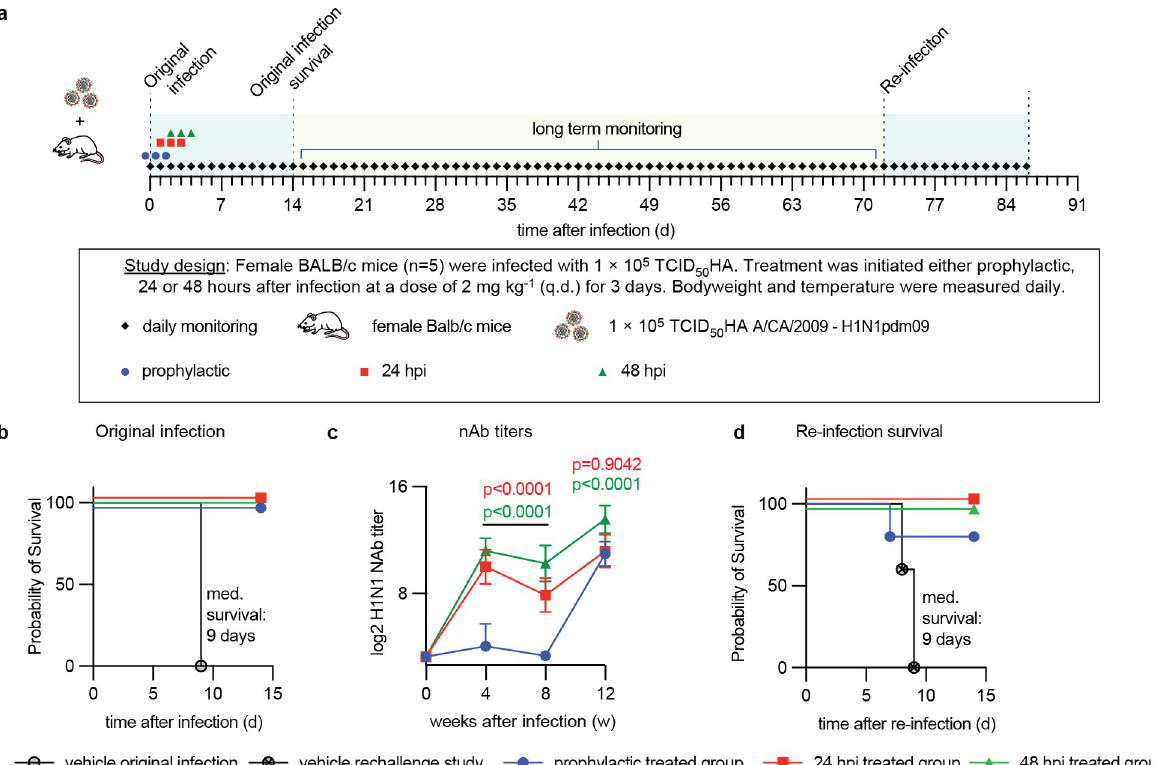
Fig 6. Reinfection of 4’-FlU-experienced animals with homotypic H1N1. a) Schematic of the treatment and reinfection study. For infection and reinfection, mice received aerosolized pdmCa09. b) Survival study of animals infected, treated, and reinfected as shown in (a). Median survival time in days is specified; Kaplan-Meier simple survival analysis. c) Anti-H1N1 neutralizing antibody (nAb) titers developing in animals from (a). Lines intersect, and symbols show, geometric means ± SD; 2-way ANOVA with Tukey’s post hoc test; P values are specified. d) Survival of animals after re-infection. Median survival time in days is specified; Kaplan-Meier simple survival analysis. N numbers for animals in (a-d) are specified in